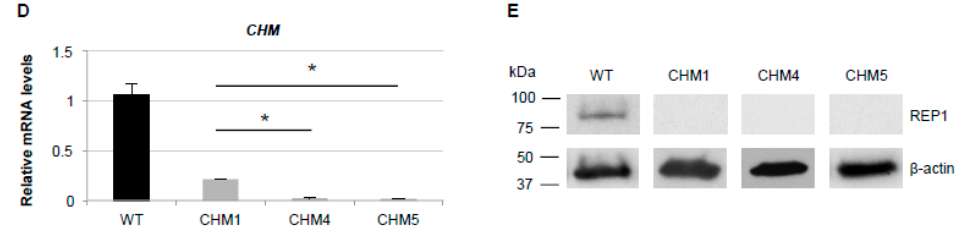
Figure 2. Pluripotency and CHM expression of the generated iPSCs. qPCR analysis showing an expression of endogenous NANOG, SOX2, OCT4 and LIN28A , relative to GAPDH expression, in CHM4 ( A ), CHM5 ( B ) and CHM1 ( C ) iPSCs (grey bars), as compared to the absence of expression in fibroblasts (C-). As a positive control, the same pluripotency markers were expressed in a previously validated wild type iPSC line (black bars). Cl1 and Cl2 indicate clone 1 and clone 2, respectively. ( D ) qPCR analysis of CHM expression (relative to GAPDH ) shows that the CHM deletion carried by the CHM4 and CHM5 iPSCs results in the absence of a CHM transcript (one clone shown for each cell line). This was significantly di ff erent to the residual transcript levels in the CHM1 iPSCs, which carry a truncating frameshift mutation (data expressed as mean ± SEM, n = 3; Mann and Whitney test p < 0.05). ( E ) REP1 protein was not detected in the CHM1, CHM4 and CHM5 iPSCs (one clone shown for each cell line), as compared to wild type (WT) cells. β -actin expression serves as the loading control.